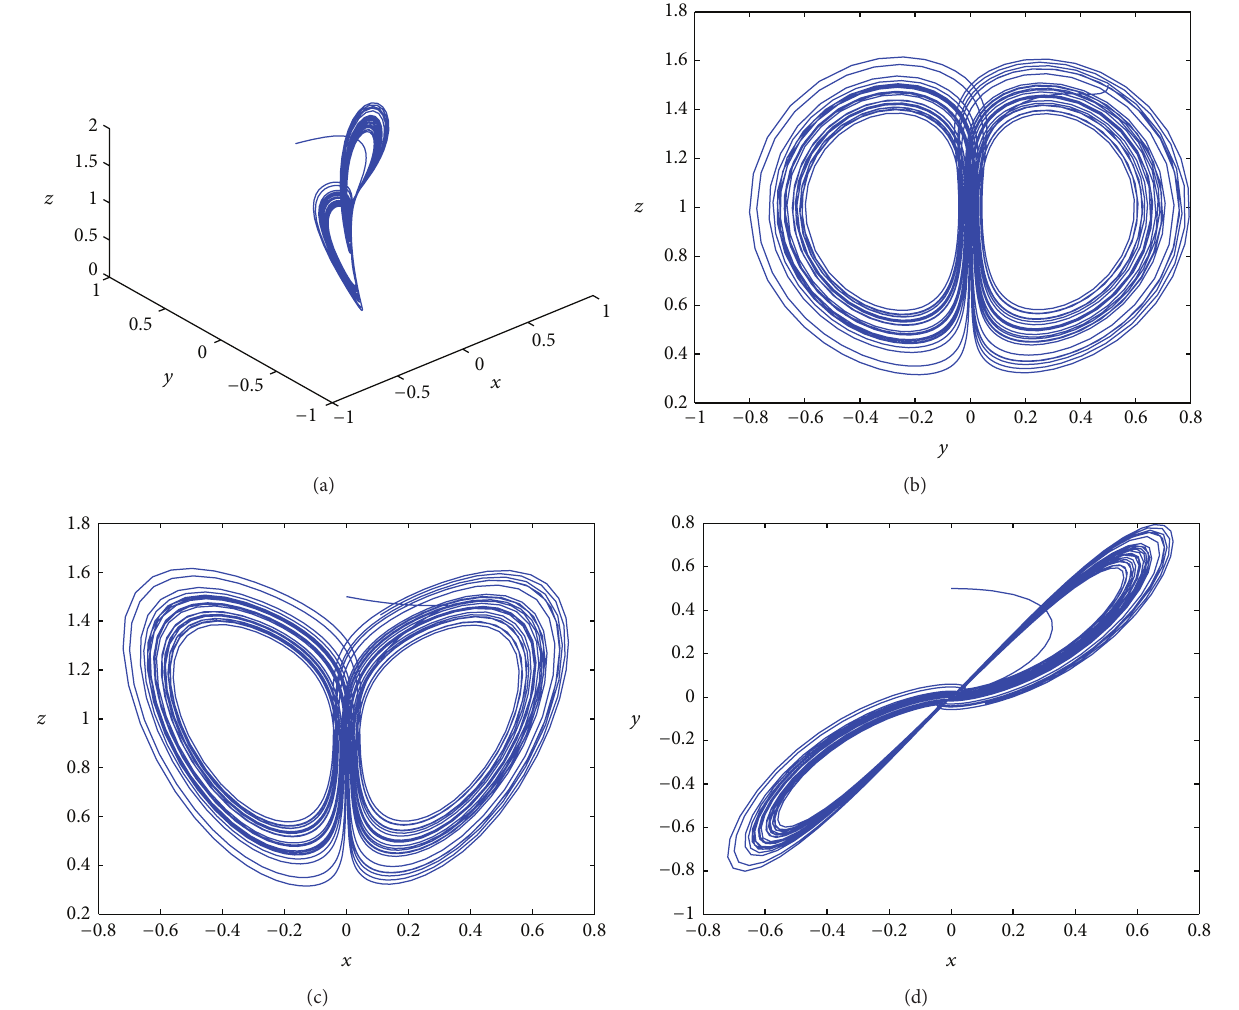
Figure 1: Phase trajectory in 3-D space and various projections of the chaotic